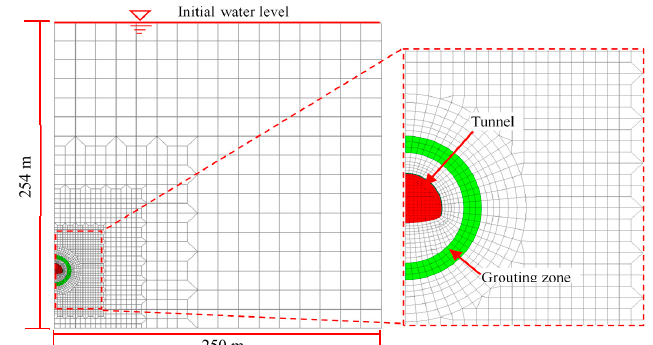
Figure 5. The sketch of the simulation model.